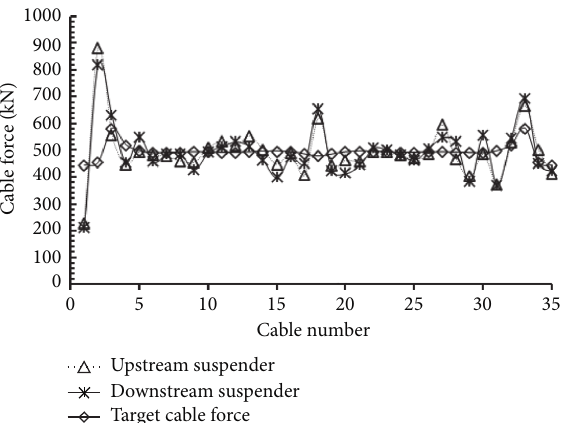
Figure 5: Comparison between measured and designed suspender tension at completion